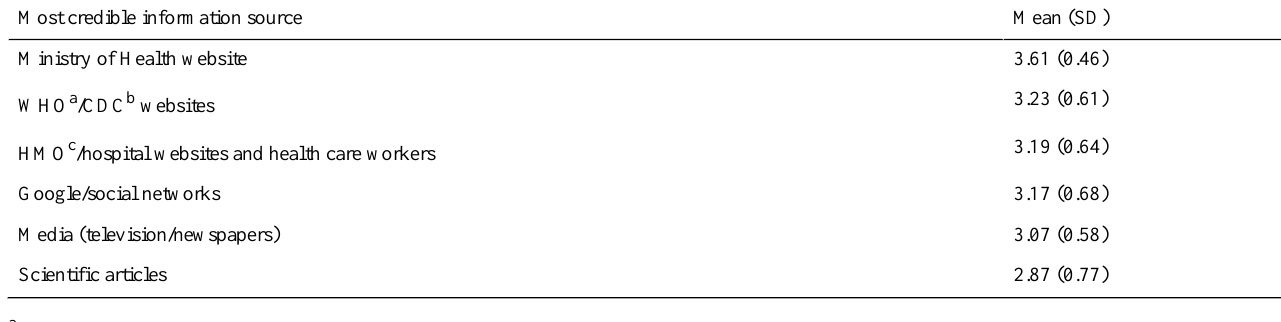
Table 6. The relationships between the most credible information sources and the attitudes toward crisis management using an ANOVA model